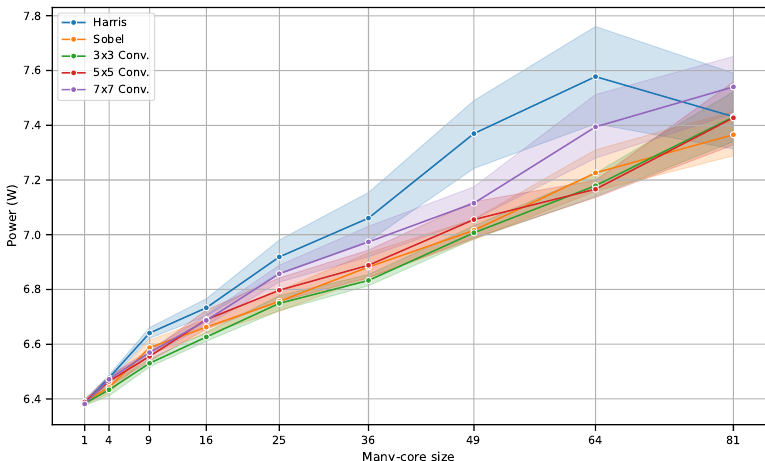
Figure 13. Power consumed for different algorithms and architecture